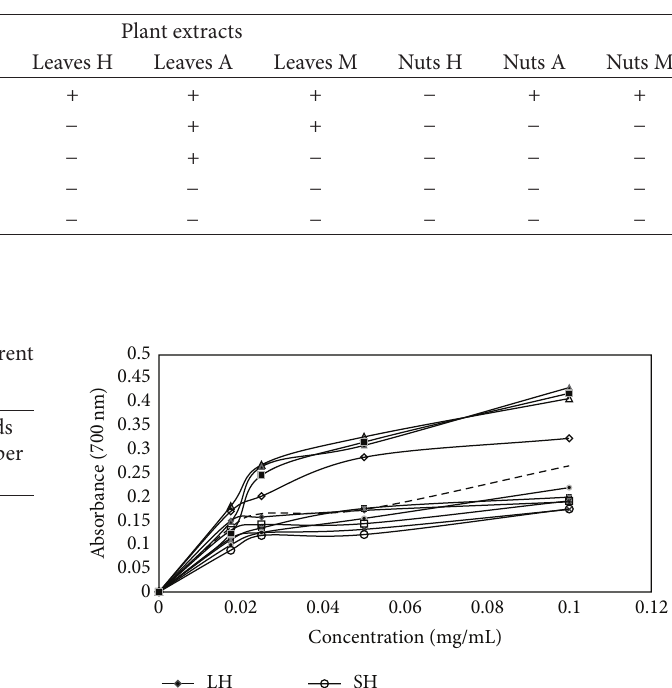
Table 3: Phytochemical analysis of chetoui O. europaea variety extracts.